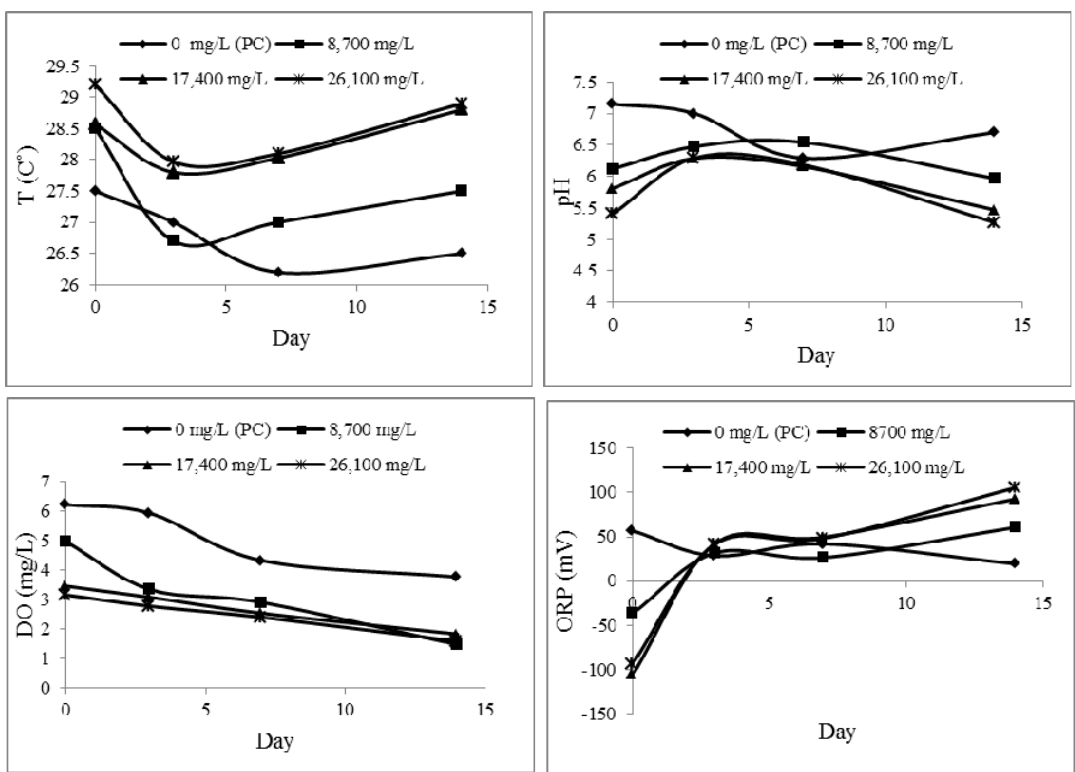
Fig. 3. Physical parameters throughout 14-day phytotoxicity test to diesel